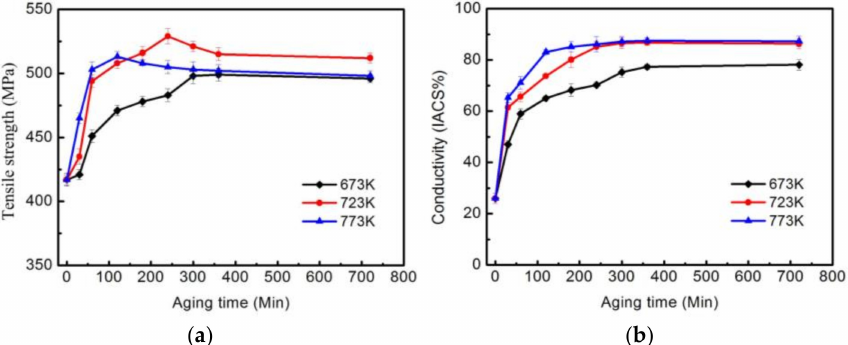
Figure 1. ( a ) Tensile strength and ( b ) electrical conductivity of the Cu-Cr-Zr alloy as a function of aging time at various